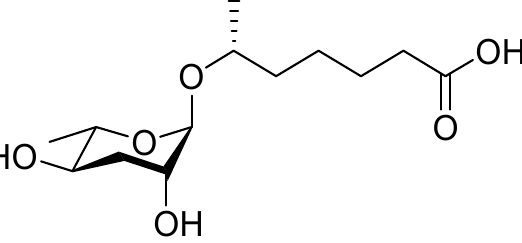
Figure 1. The chemical structure of daumone, the first characterized ascaroside (ascr) pheromone ( ascr#1 ), contains an ascarylose sugar and a methylated short-chain fatty acid (mSCFA) linked by an ether bond [(2)-(6R)-(3,5-dihydroxy-6-methyltetrahydropyran-2-yloxy) heptanoic acid] [13].